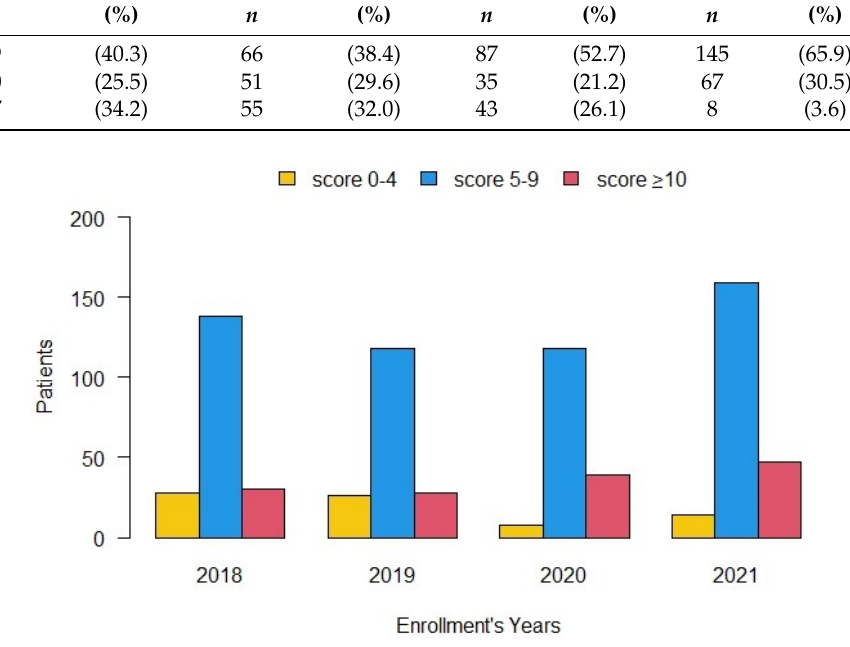
Figure 4. Enrollment of patients according to referral form score and year of referral.